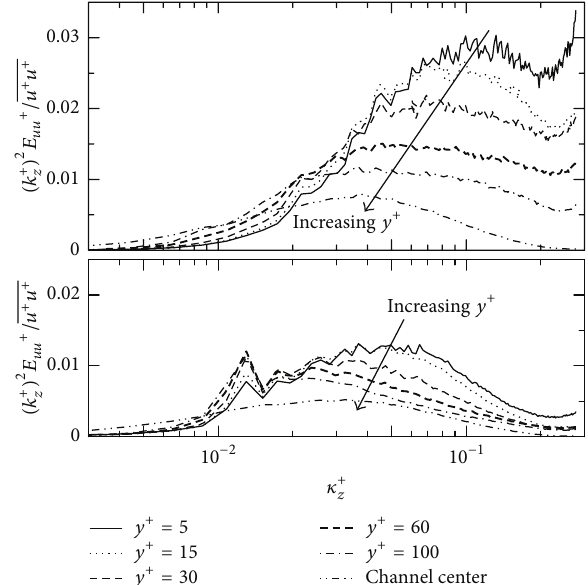
Figure 3: Premultiplied one-dimensional spanwise energy spectra of streamwise velocity fluctuation in drag-reducing viscoelastic flow at Re 𝜏 = 395 . (a) Wi 𝜏 = 10 , 𝛽 = 0.8 and (b) Wi 𝜏 = 30 , 𝛽 = 0.5